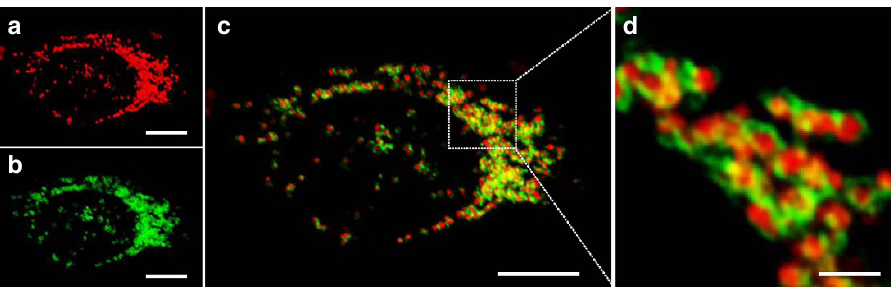
Figure 6 | Identification of subcellular NIR-fluorescent on switch. CLSM fluorescent images showing lysosomal localization of the ‘on’ state of 2 in LAMP1-GFP-expressing HeLa cells ( a ) Cy5.5 channel; ( b ) GFP channel. ( c ) Three-dimensional image of overlaid Cy5.5 and GFP channels. ( d ) Zoom-in of the dashed box. Scale bars, 10 m m ( a – c ) and 2 m m ( d ).